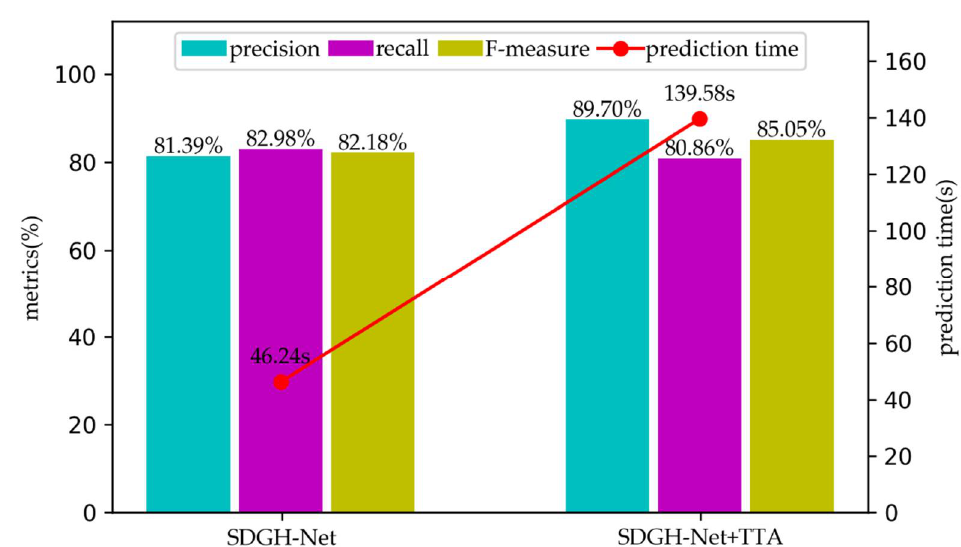
Figure 11. Metrics scores and prediction times of the comparative experiment with or without TTA. The blue column represents precision, the purple column represents recall, the yellow column represents F-measure, and the red dot represents the prediction time.